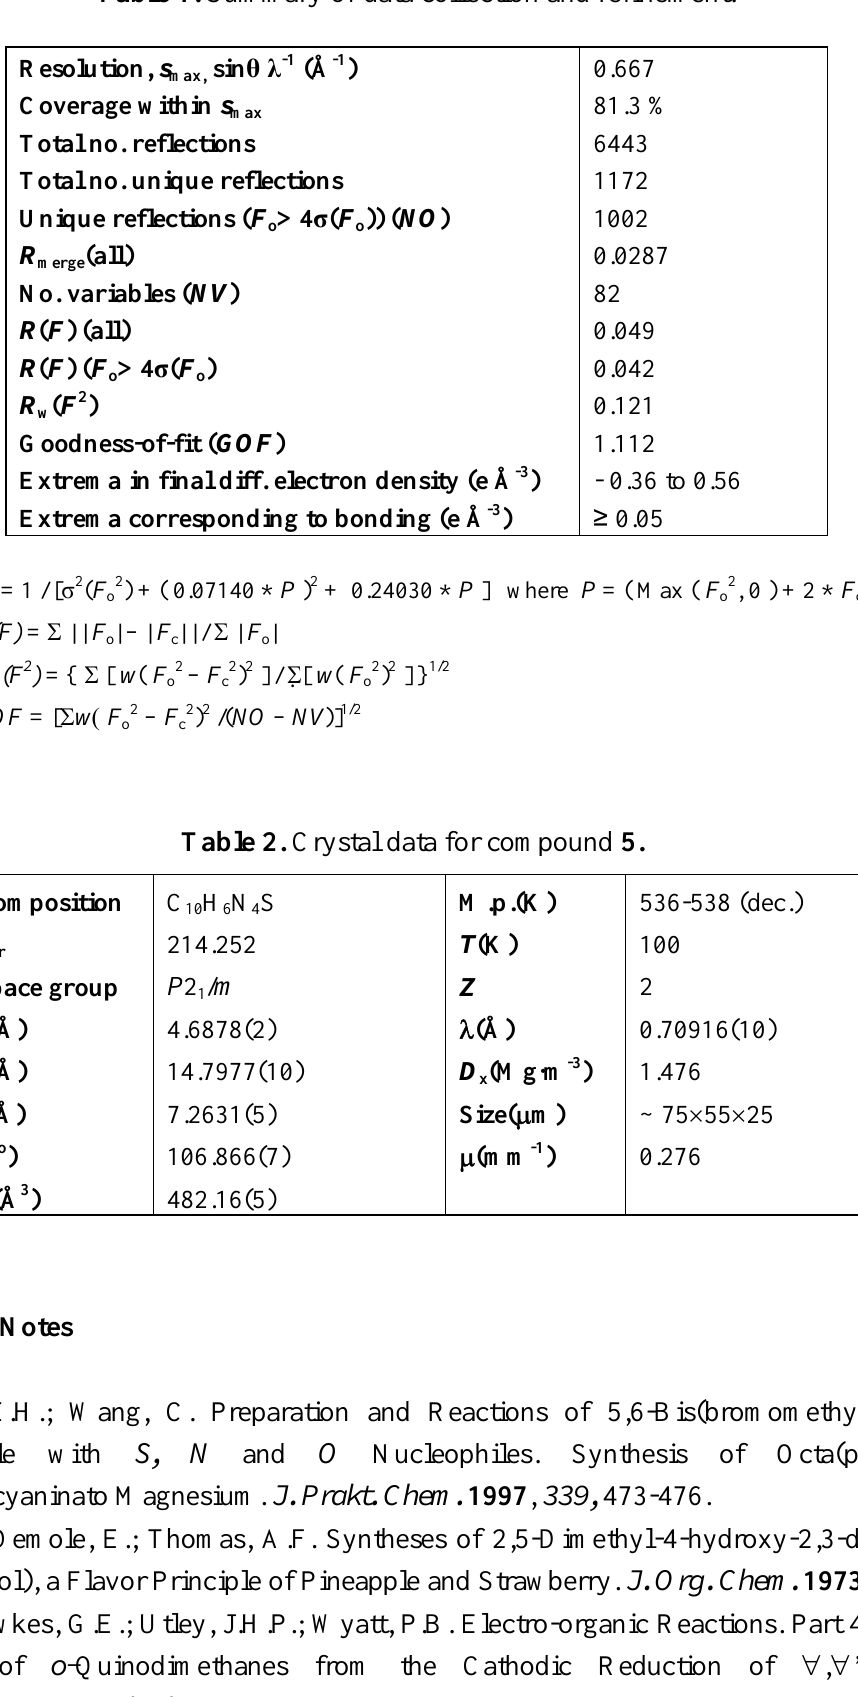
Table 1. Summary of data collection and refinement.